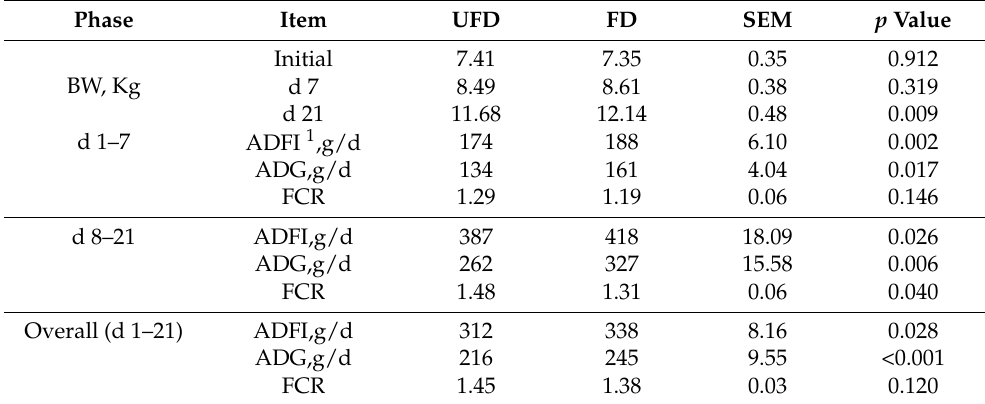
Table 3. Effect of dietary supplementation with FFS on growth performance in weaned pigs.